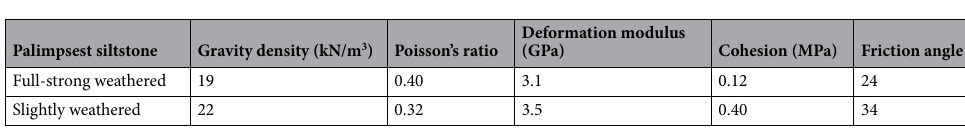
Table 5. Rock parameters of Lijiazhai